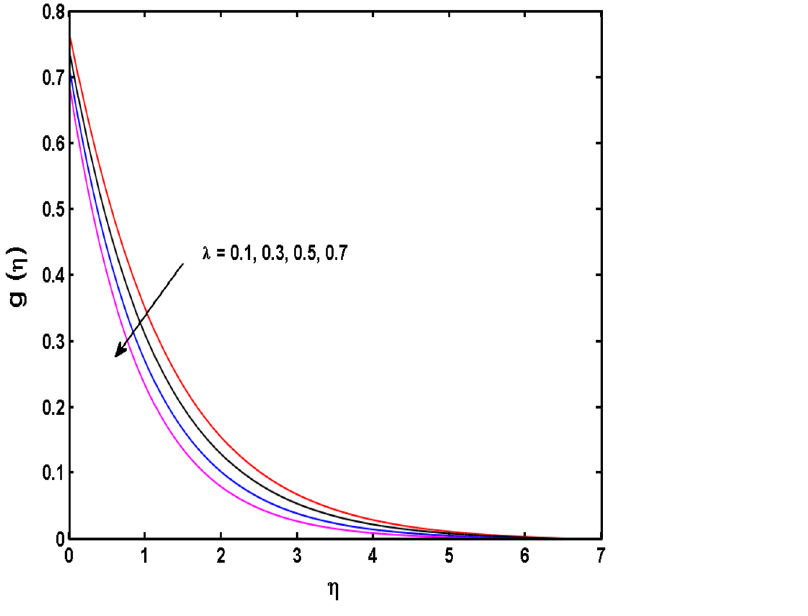
Figure 9. Variations of (cid:31) to g (η)